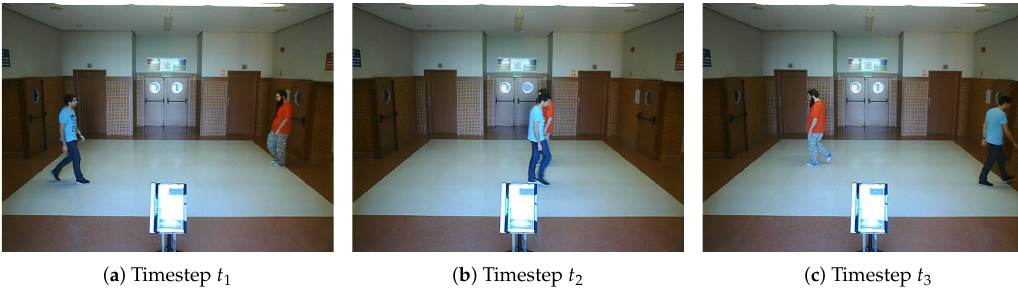
Figure 11. Real scenario 1—Images sequence.